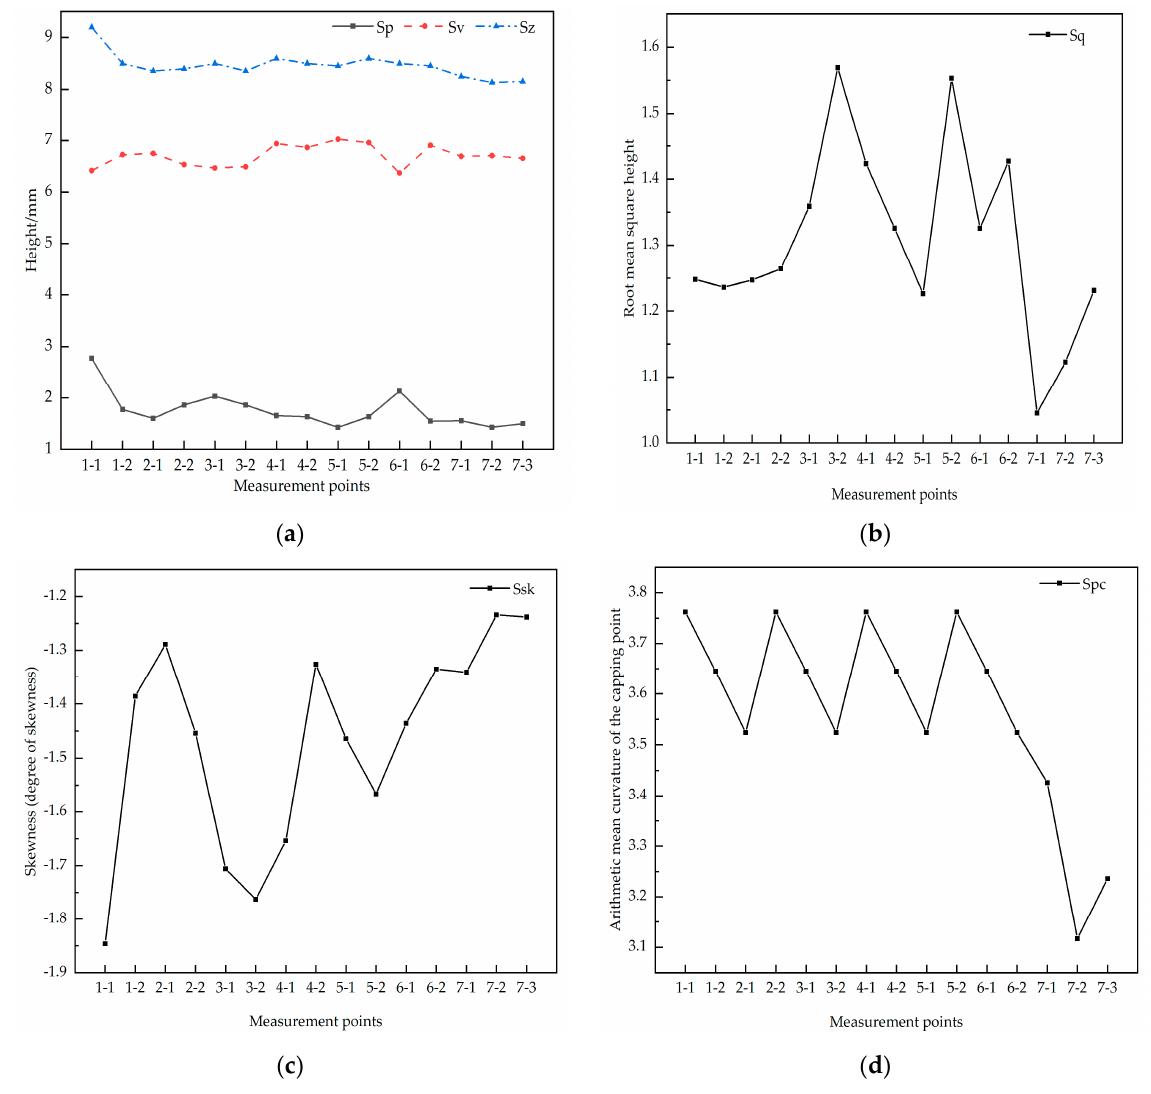
Figure 19. Texture values for di ff erent measurement points. ( a ) Sp, Sv, Sz for di ff erent measurement points; ( b ) Sq for di ff erent measurement points; ( c ) Ssk for di ff erent measurement points; ( d ) Spc for di ff erent measurement points.